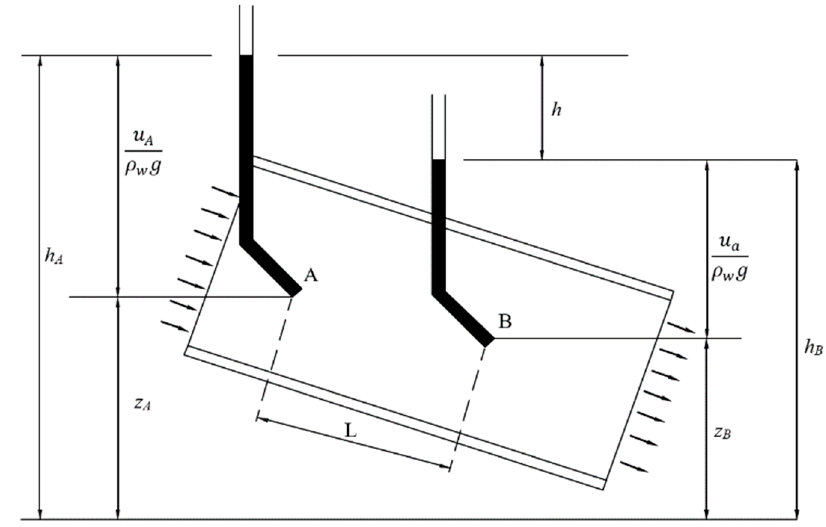
Figure 2. Head loss as water flows through a porous media [7].